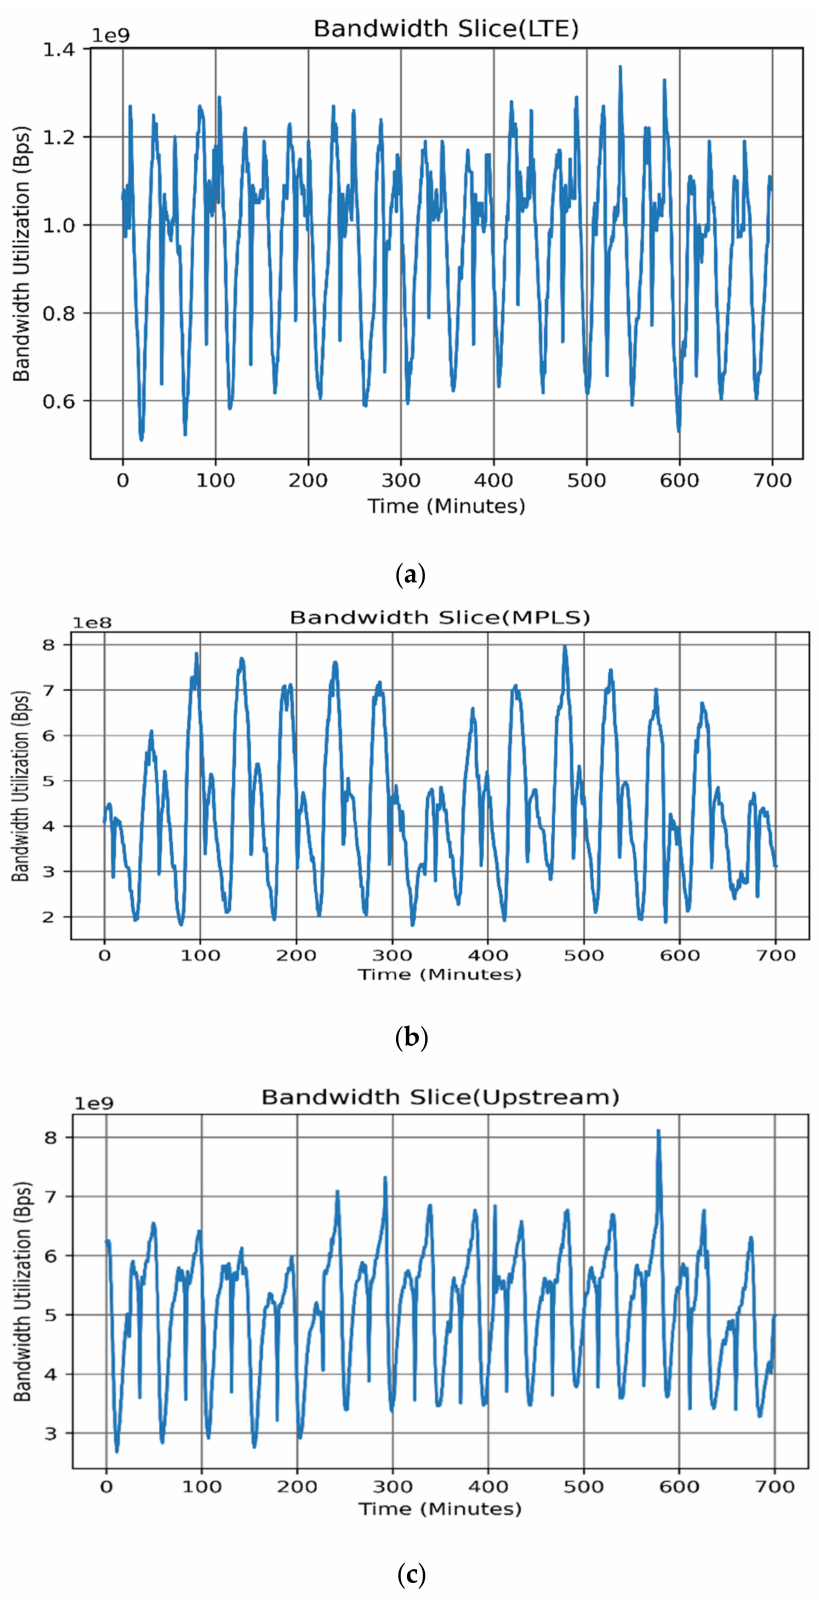
Figure 3. Backbone bandwidth slices: ( a ) LTE, ( b ) MPLS, and ( c ) upstream